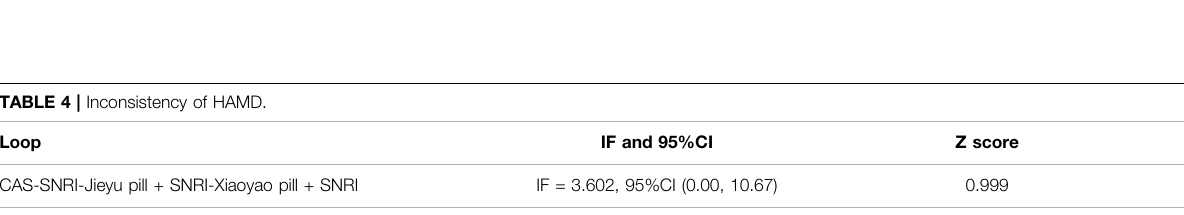
FIGURE 4 | Funnel plot of (A) total effective rate, (B) HAMD, and (C) adverse reactions.